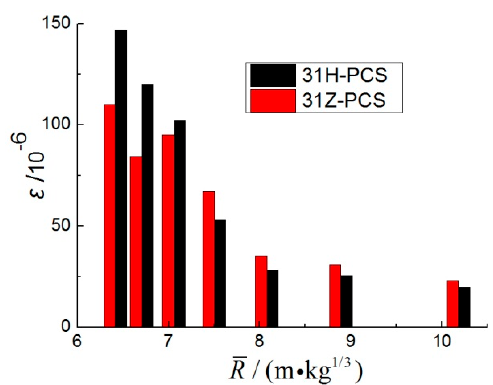
Figure 9. The PCS of 31H and 31Z ( R = 3.75